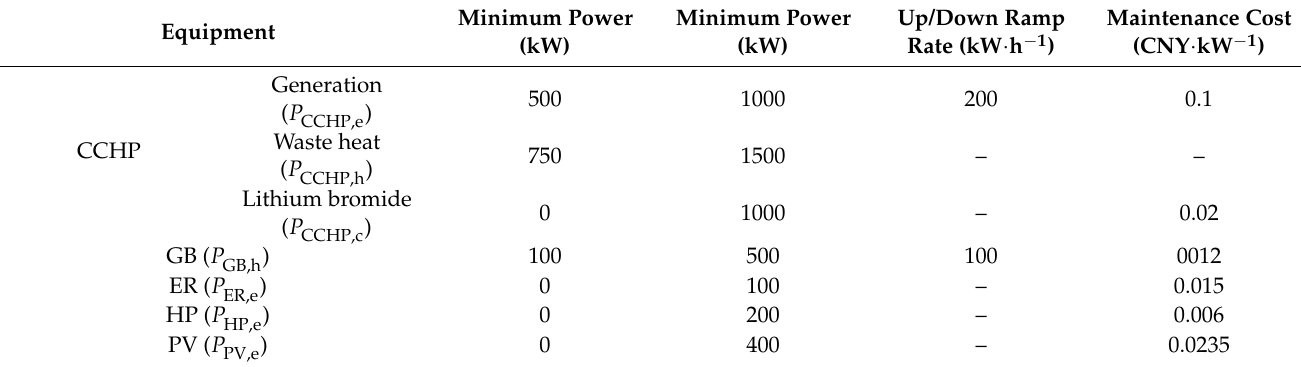
Table 3. The equipment parameters of energy stations.